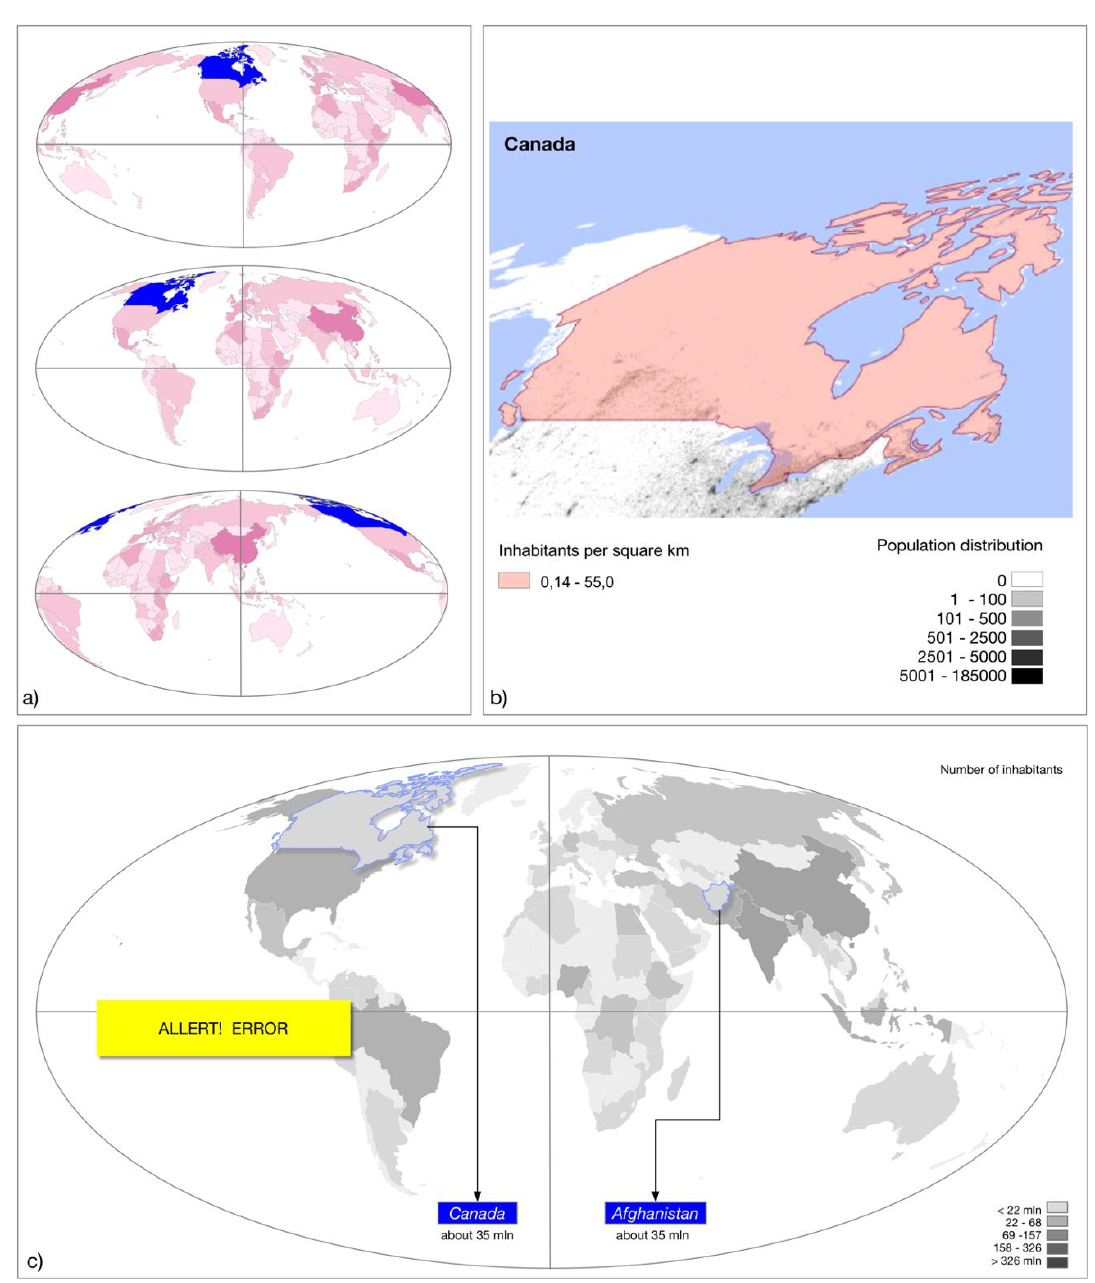
Figure 6. Administrative units: ( a ) Different perspectives on the Mollweide projection and the effect on the shape of a unit (Canada); ( b ) Transparent choropleth with population distribution as basemap (non-homogeneous distribution of Canadian population) ( c ) The most common error with choropleth maps: use of absolute numbers (here inhabitants per country — Canada and Afghanistan have about same population but this will not be perceived like this because of size differences.